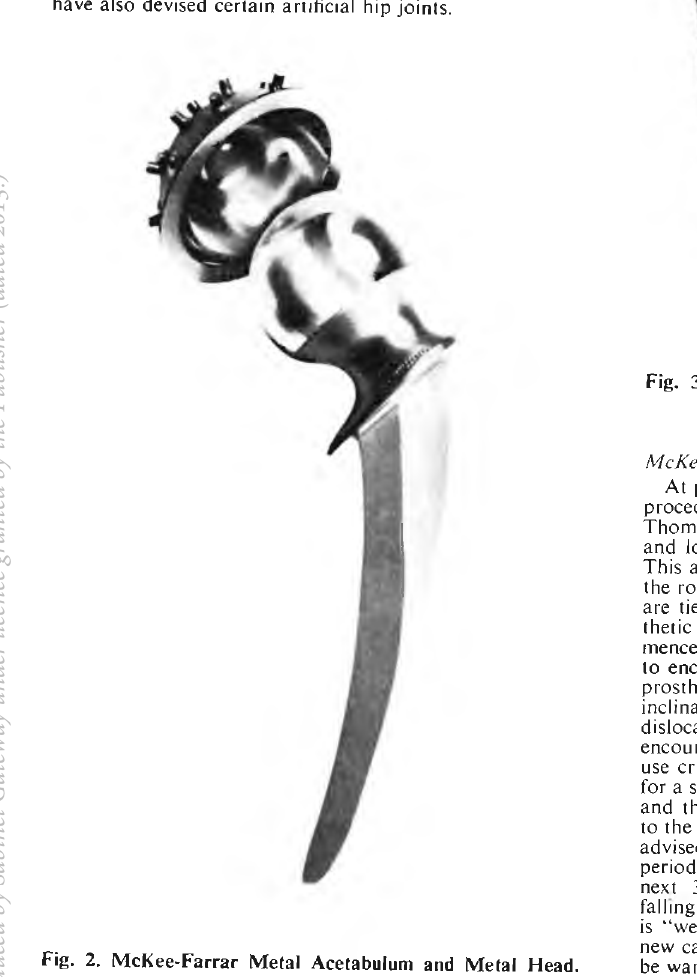
Fig. 2. McKee-Farrar Metal Acetabulum and Metal